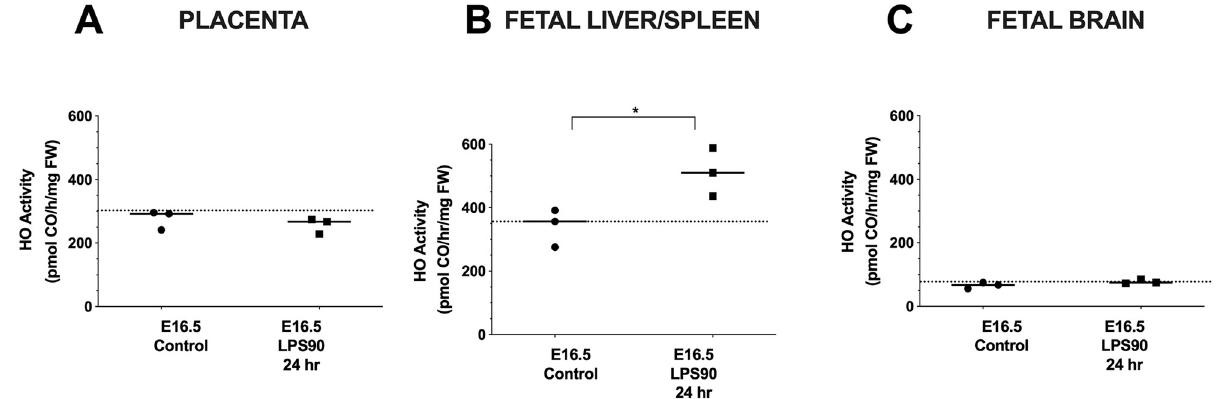
Fig 4. HO activity in placentas and fetal organs after LPS at a dose of 90 ug/kg (LPS90). LPS was administered i.p. to pregnant Wt dams, at E15.5 (Control (Veh), n = 3; LPS90, n = 3) and HO activity was measured 24 hrs later. ( A ) Placental HO activity was unchanged. ( B ) Fetal liver/spleen HO activity significantly increased 24 hrs after LPS exposure. p < 0.05, Welch’s t-test. ( C ) Fetal brain HO activity was unchanged when measured at E16.5. FW: fresh weight. (Data is normally distributed for placenta and fetal liver/spleen and brain.).